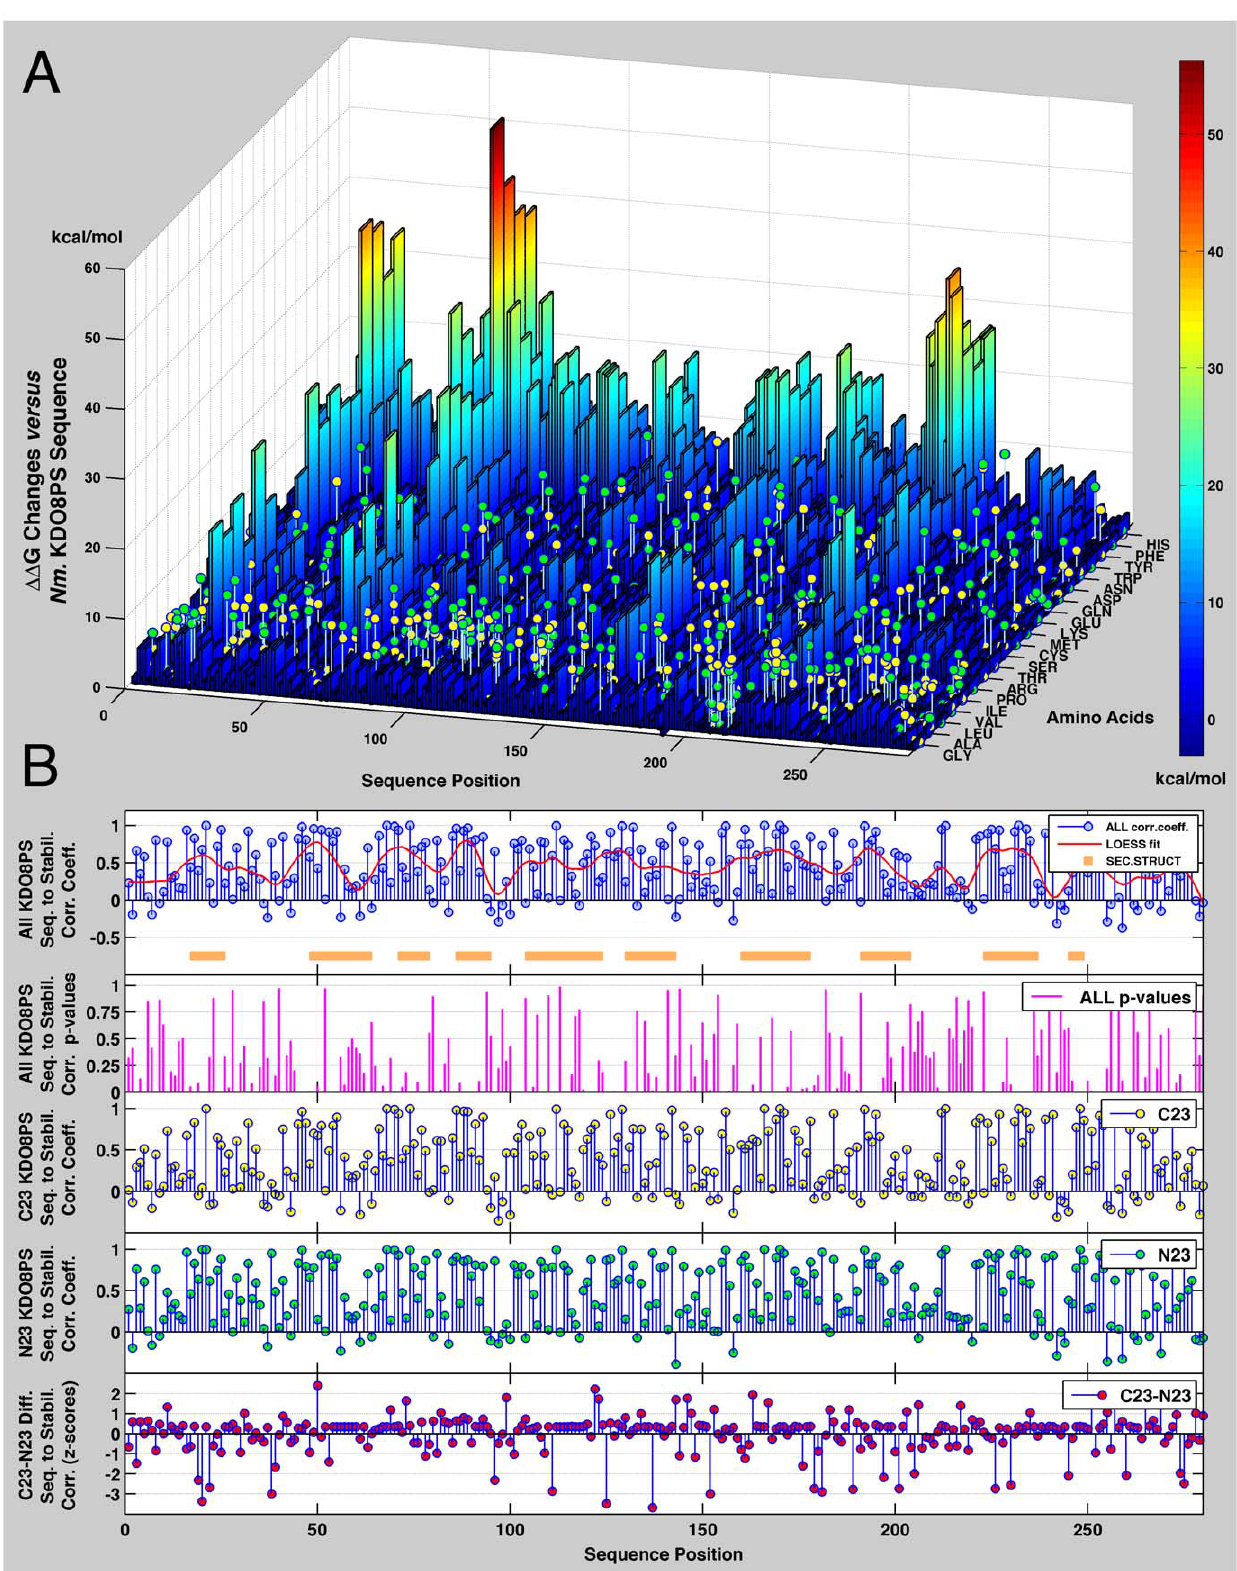
Figure 2. Stability landscape of KDO8PS. A. DD G changes associated with introducing any one of the 20 possible amino acids at each position of all four subunits of the structure of Nm. KDO8PS were calculated using the FoldX algorithm to produce a ‘‘stability landscape’’ of KDO8PS: the peaks in the landscape represent positions in the protein where introduction of a certain amino acid would significantly decrease the overall stability. The observed frequency of different amino acids at each position in the two subfamilies of C23 and N23 KDO8PSs is superimposed to the stability